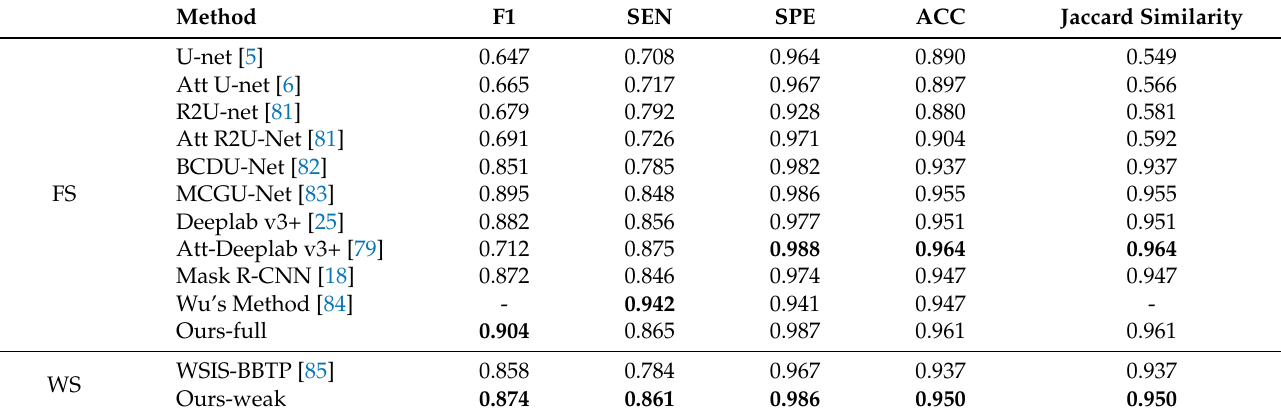
Table 2. Performance comparison of the proposed segmentation network and other methods on the ISIC 2018 dataset.